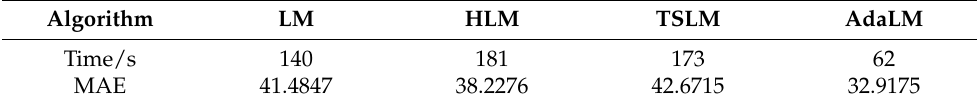
Table 3. MAE and time consumption of each